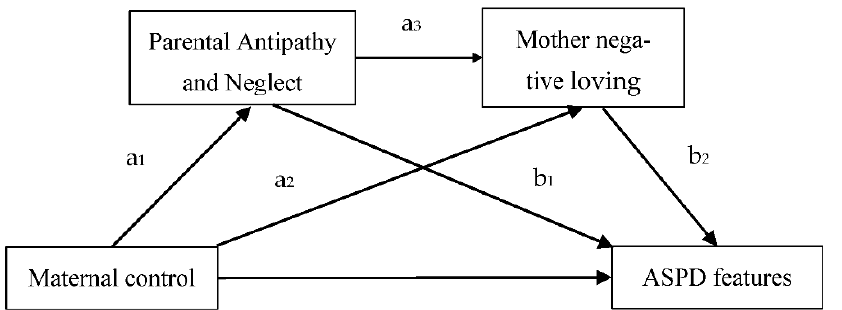
Figure 1. A sequential mediation model of maternal control, PAN, mother negative loving and ASPD. Note. The a 1 , a 2 , a 3 , b 1 and b 2 , respectively, refer to the regression coefficients of different paths in this sequential mediation model.